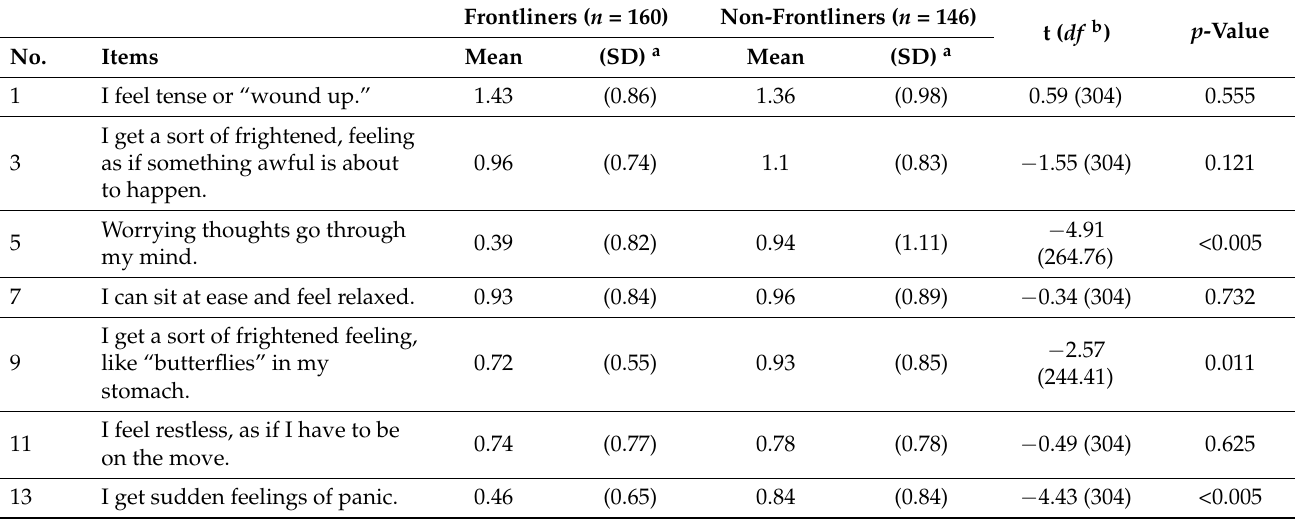
Table 2. Healthcare providers’ scores on the Hamilton Anxiety Depression Scale–Anxiety.